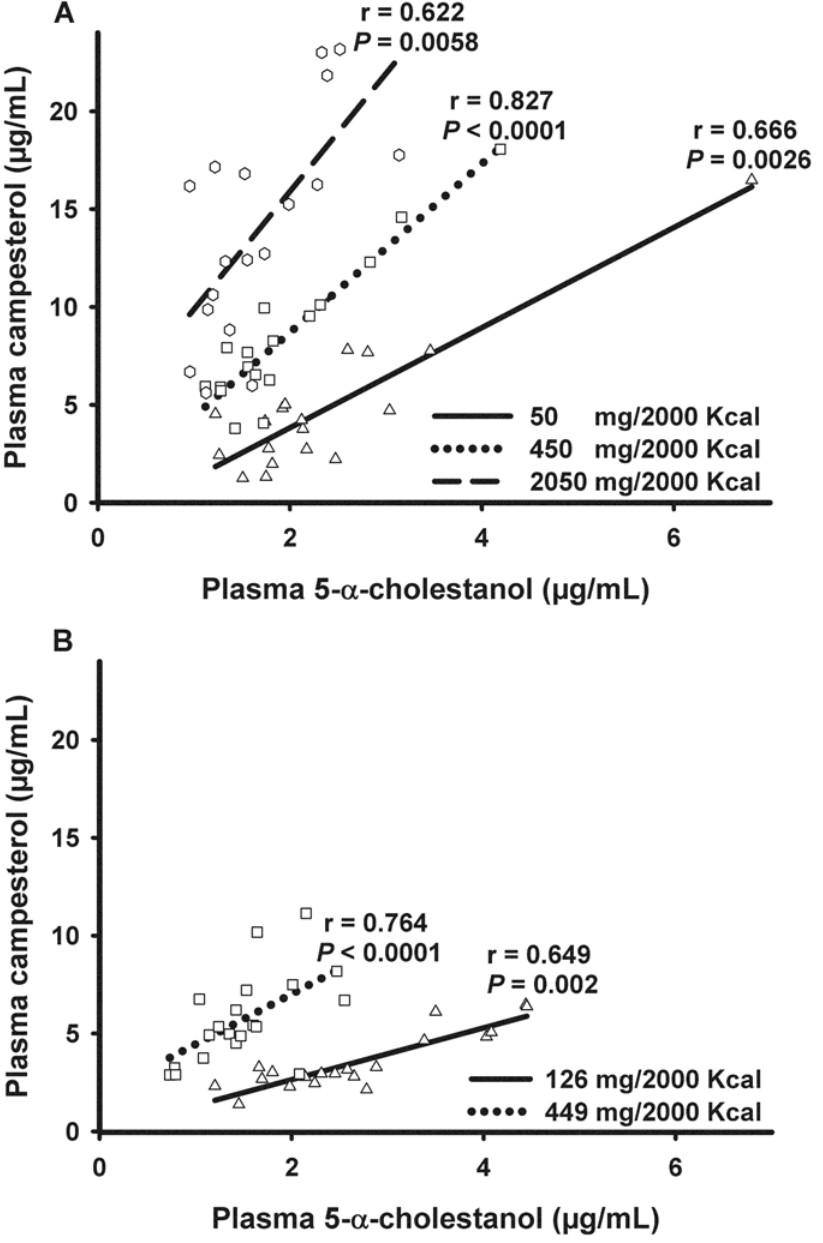
Fig 3. Correlations between plasma non-cholesterol sterol concentrations at each dietary phytosterol intake level. Values reflect Spearman ’ s rank-order correlation coefficients in the Supplement Study (A) and the Natural Study